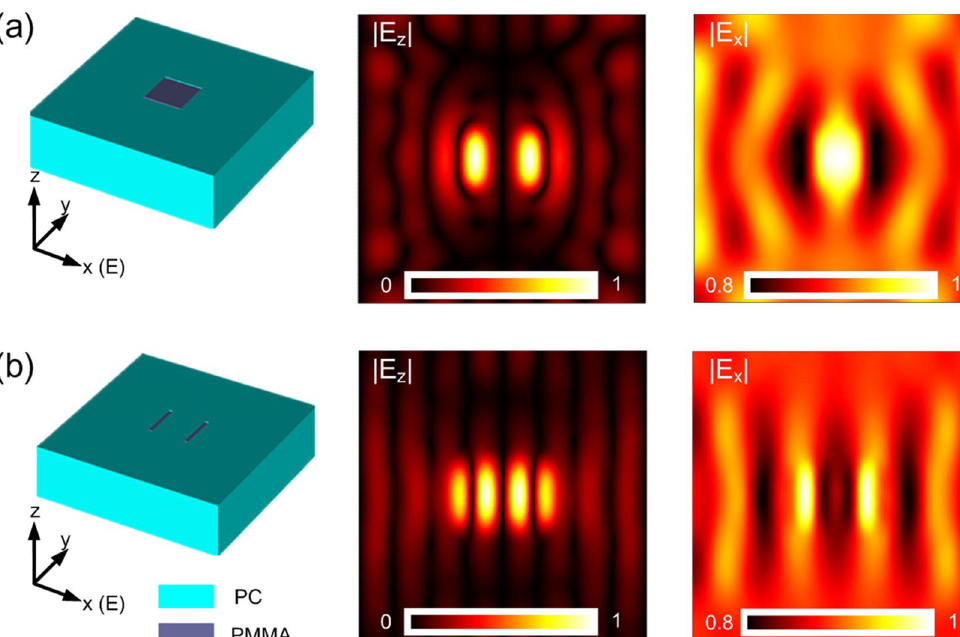
Figure 6. Detecting performance of the HPEDL in three-dimensional simulations. The HPEDL is used to detect two related patterns: ( a ) a square PMMA with 200 nm width; ( b ) two PMMA strips with 20 nm width and 200 nm long, the center-to-center separation of the strips is chosen to be 200 nm. The simulated electric-field distributions | E z | and | E x | for both structures are